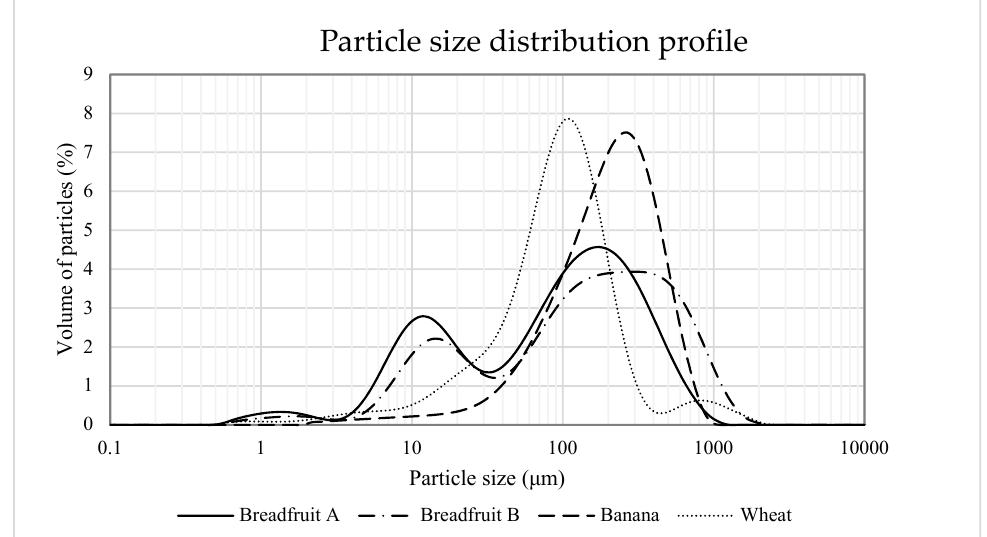
Figure 1. Particle size distribution profiles of tropical flours compared with a traditional flour. Treatments were flour types of breadfruit A, breadfruit B, banana, or wheat. Breadfruit flour A was sourced from Natural Foods International (Apia, Western Samoa). Breadfruit flour B was sourced from Jungle Project (Alajuela, Costa Rica). Banana flour was sourced from LiveKuna, Kunachia LLC (Davie, FL, USA). Wheat flour was obtained commercially from Bulk Barn Foods (Aurora, ON, Canada).